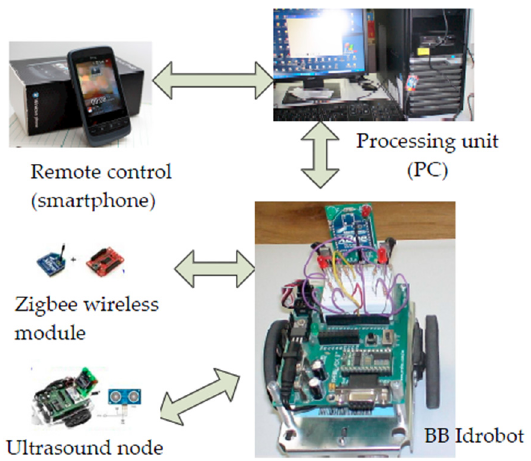
Figure 12. Experiment setup.